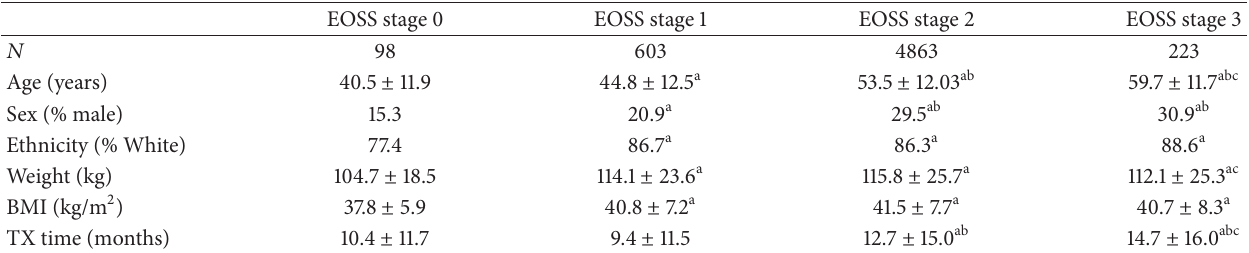
Table 2: Characteristics of patients attending a publicly funded multisite weight management clinic among EOSS stages 0 to 3.